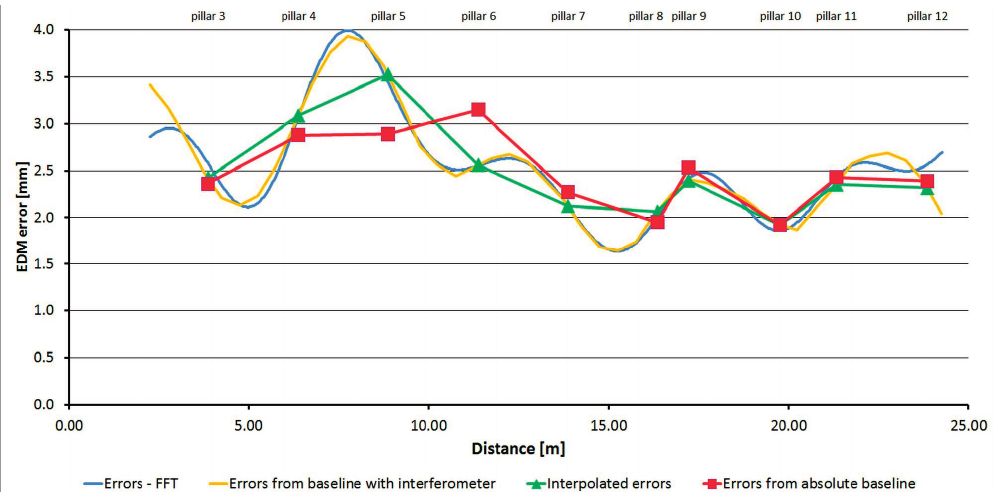
Figure 34. The resulting graph of the combination of absolute and relative errors and the correcting function by FFT–Topcon GPT-7501.